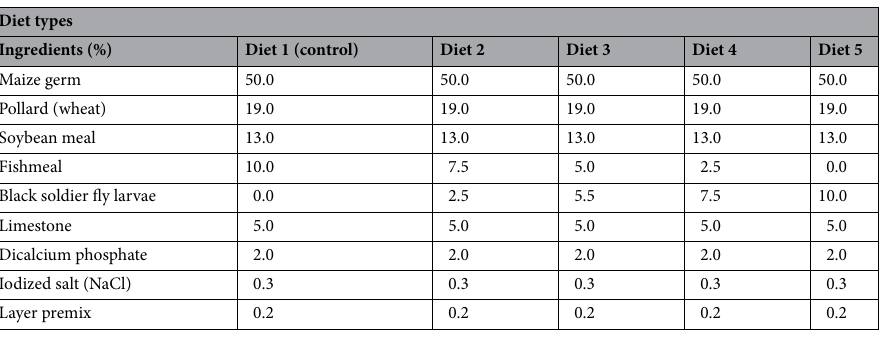
Table 2. Feed composition of the formulated diets fed to grower layer chicken for a period of twelve (12) weeks 26 . Super layer premix contents per 2.5 kg: Vit. (Vitamin) A: 8,000,000 IU/kg, Vit. D3:2,000,000 IU/ kg, Vit. E: 3000 mg, Vit. K3: 2000 mg, Vit B2: 3500 mg, Pantothenic Acid: 6600 mg, Niacin: 20,000 mg, Folic Acid: 550 mg, Vit. B12: 6 mg, Choline chloride: 200,000 mg, Lysine: 350 mg, Methionine: 120 mg, Manganese: 63,000 mg, Iron: 23,000 mg, zinc: 63,000 mg, Copper: 14,000 mg, Cobalt: 1000 mg, Iodine: 2000 mg, Selenium: 100 mg and BHT: 120,000 mg. Abbreviation: BSFL- black soldier fly larvae. FM- fishmeal Diet 1—0%